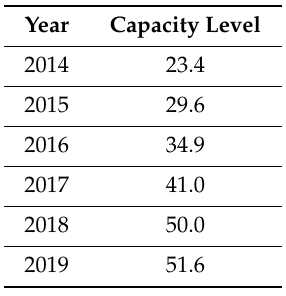
Table 3. Capacity Level of older people by